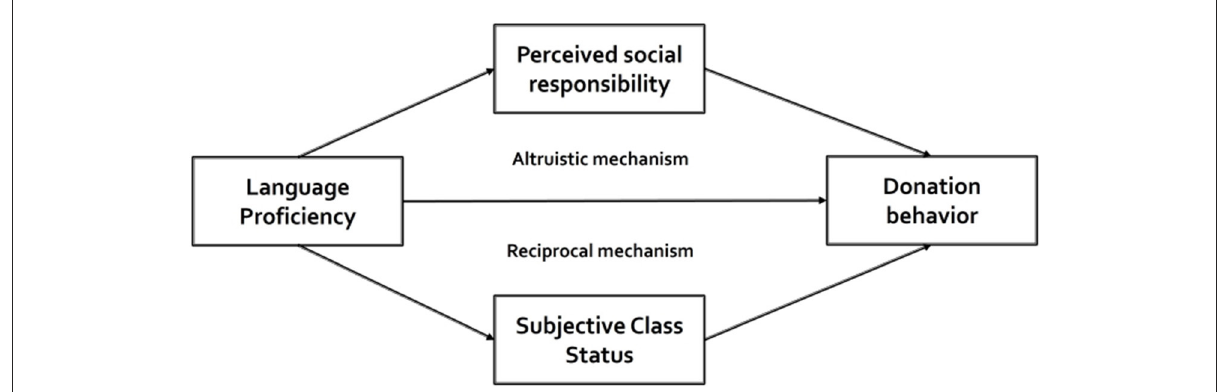
FIGURE1 The theoretical